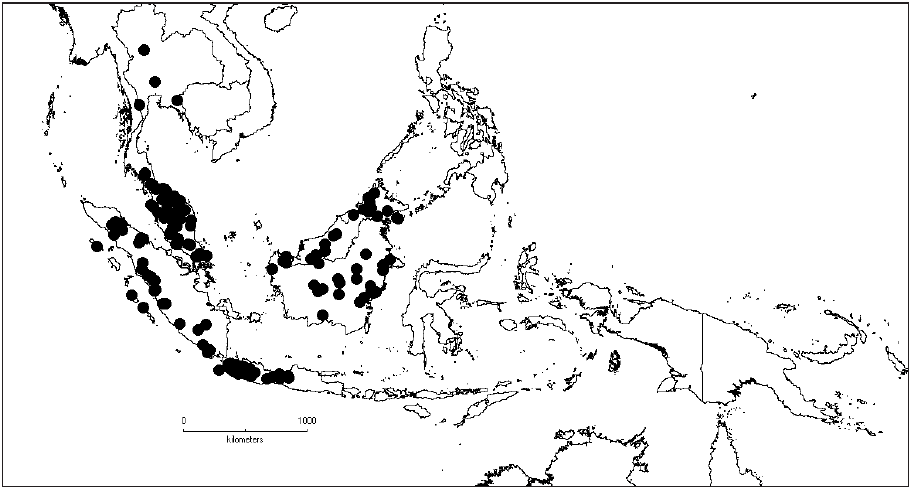
Map 16. Distribution of D. gracilis ( ●